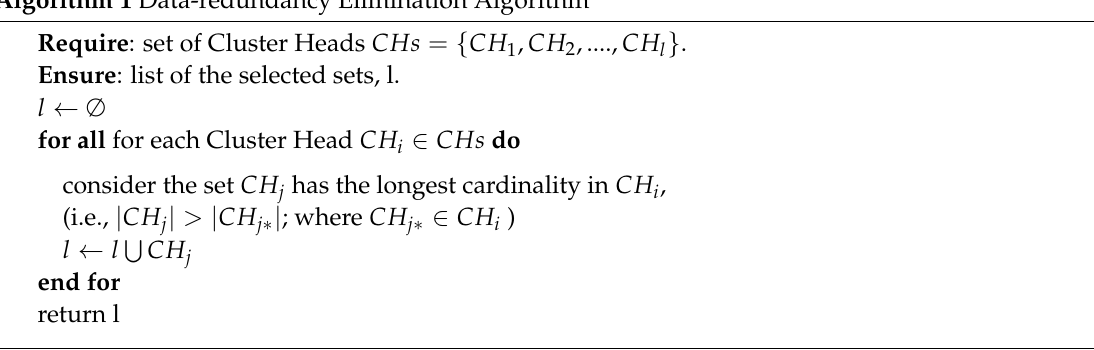
Algorithm 1 Data-redundancy Elimination